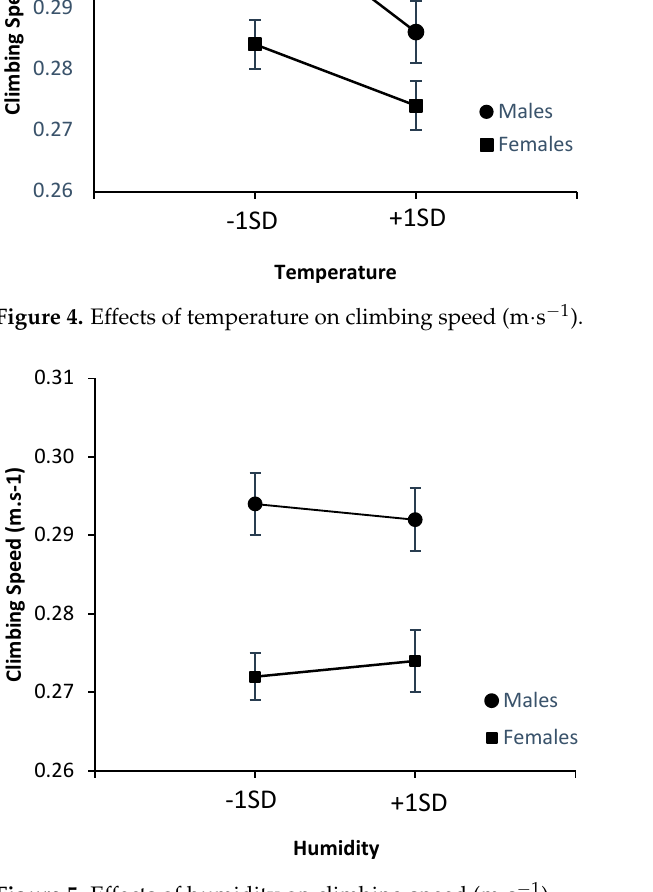
Figure 5. Effects of humidity on climbing speed (m · s − 1